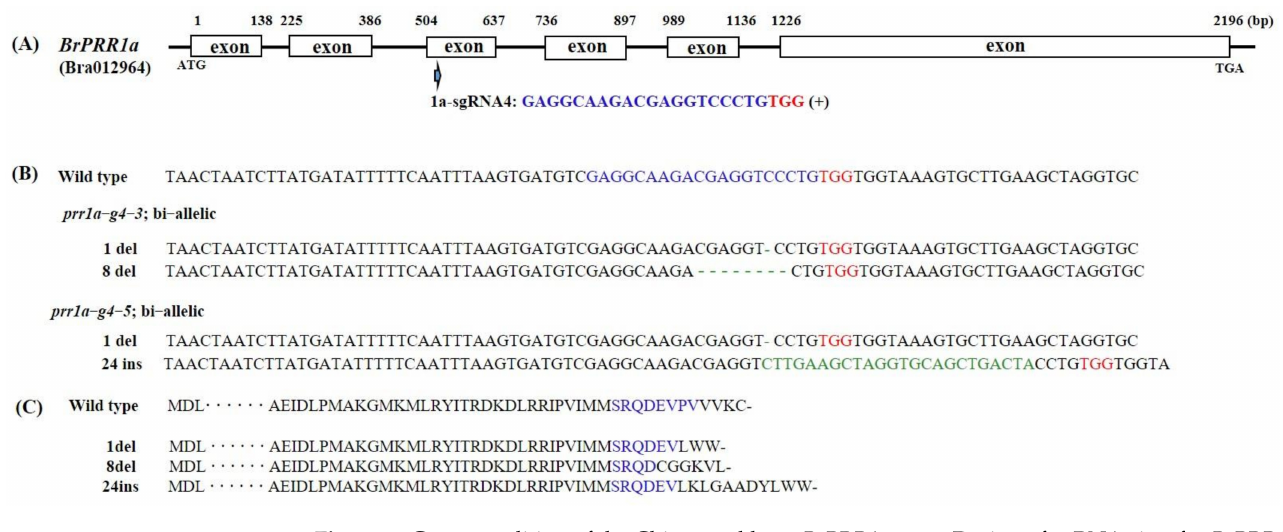
Figure 2. Genome editing of the Chinese cabbage BrPRR1a gene. Design of sgRNA sites for BrPRR1a exons. The PAM motif (NGG) is shown in red ( A ). Next-generation sequencing (NGS) alignment of the sgRNA target region in different mutant lines. Deletions and insertions are indicated by dashes and green letters, respectively ( B ). Amino acid sequences of wildtype and generated mutations are shown ( C ). The sgRNA and PAM site are represented in blue and red. Stop codon is shown with black dash.